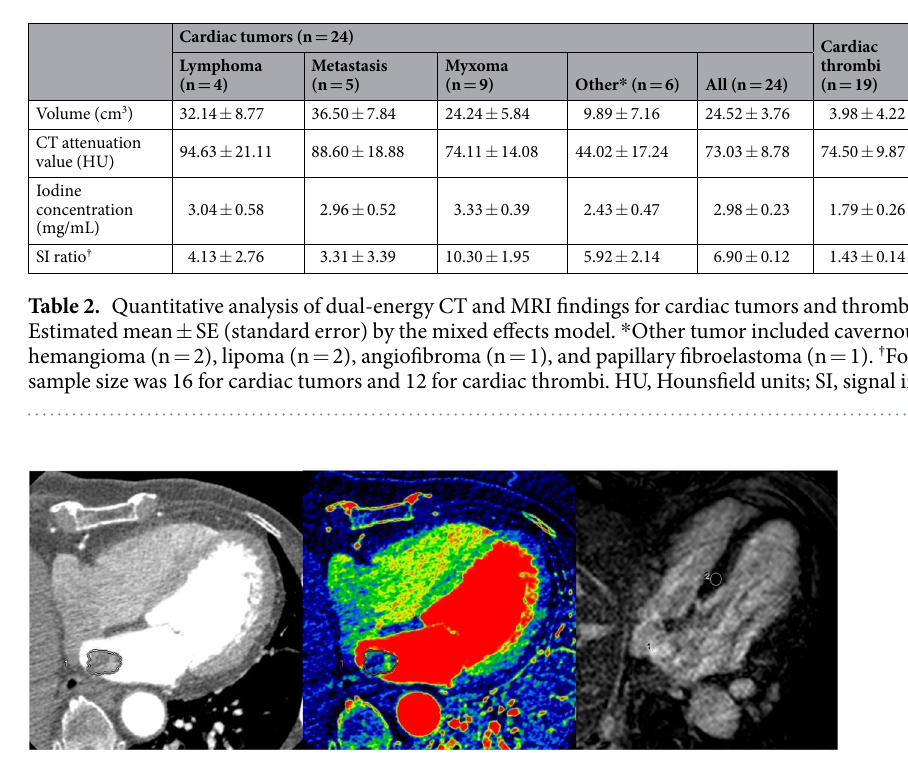
Figure 1. A 72-year-old female patient diagnosed with a myxoma. ( A ) On enhanced CT, a 2.4 × 1.5-cm well- defined mass was noted in the left atrium. The volume of the mass was 3.37 cm 3 and the CT attenuation value of the intra-cardiac mass was 40.00 HU. ( B ) On the iodine (water) image, the iodine concentration of the mass within the VOI was 5.04 mg/ml. ( C ) On LGE image, the mass shows strong contrast enhancement; the SI ratio of the mass was 20.50.